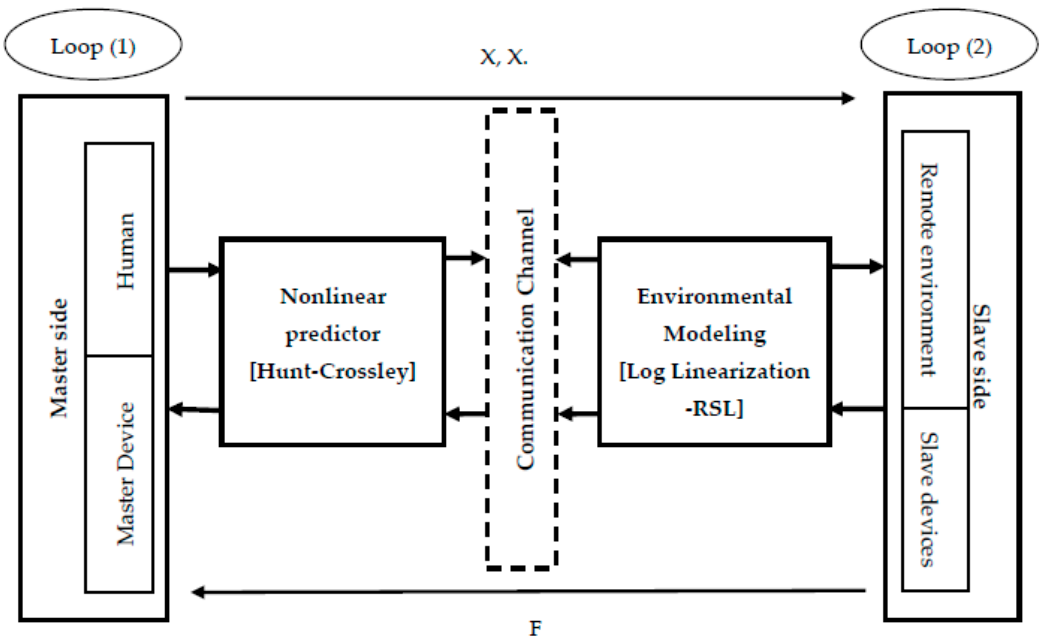
Figure 7. System structure of the model mediated bilateral teleoperated system developed in [81].